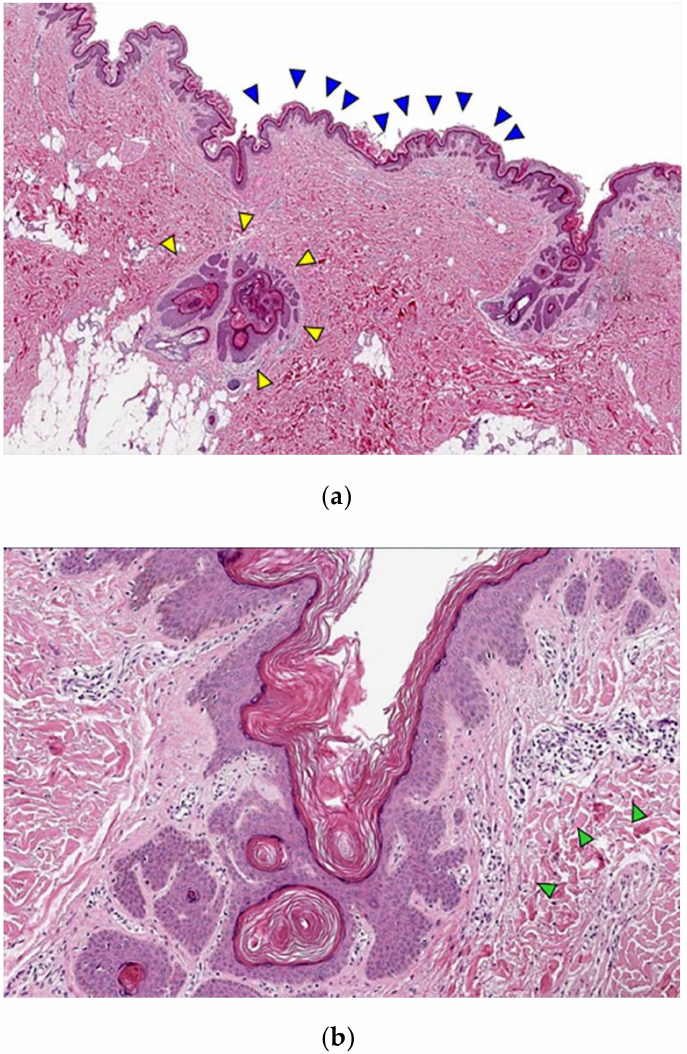
Figure 3. Representative microscopic images of nevus comedonicus. ( a ) Papillomatous epidermal hyperplasia (blue arrowhead) and invaginations with a laminated keratin plug (yellow arrowhead); ( b ) Mild perivascular and perifollicular lymphocytic infiltration (green arrowhead). (H & E, ( a ) × 12.5; ( b ) × 40